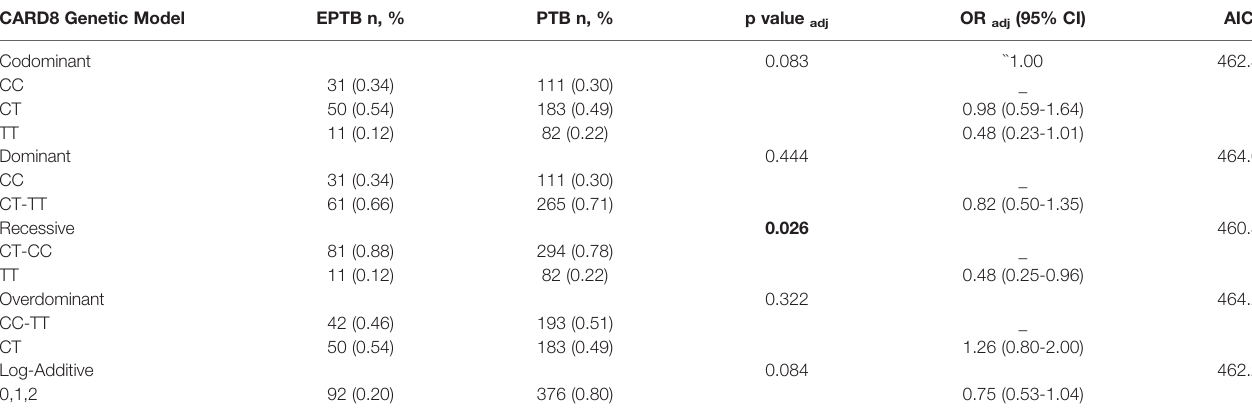
TABLE 2 | Genetic models of association SNV rs2009373 of CARD8 gene adjusted for sex and age in patients with extrapulmonary tuberculosis (EPTB) and pulmonary tuberculosis (PTB). CARD8 Genetic Model